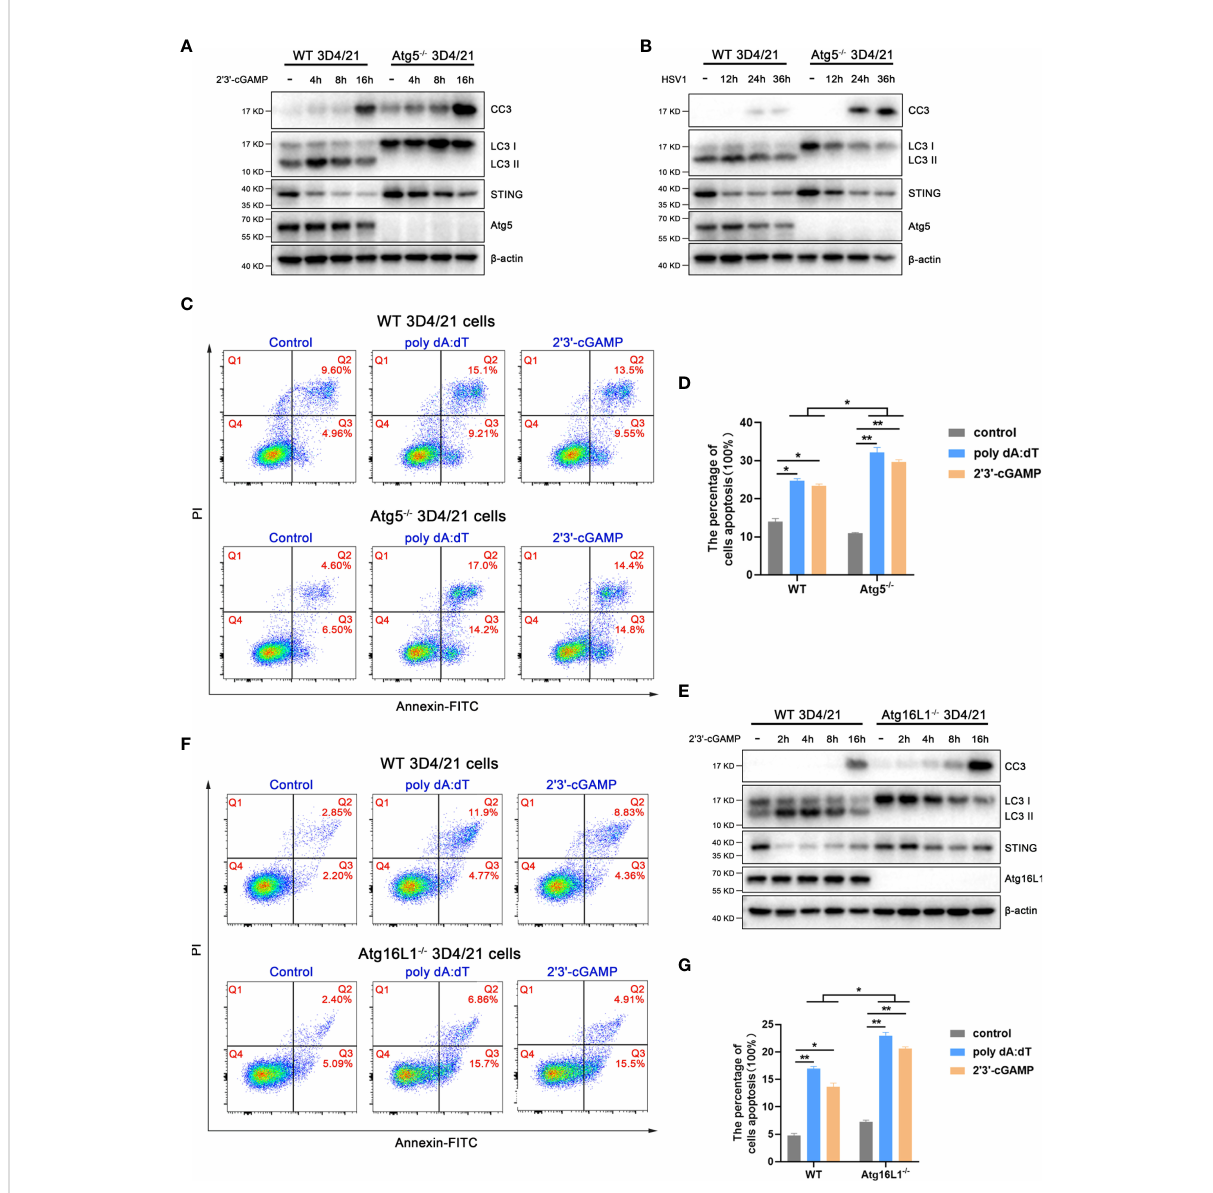
FIGURE 7 STING induced autophagy promotes STING degradation and inhibits apoptosis. (A, B) Wild type and Atg5 -/- 3D4/21 cells were stimulated by 2 ’ 3 ’ -cGAMP (1 m g/mL) (A) or HSV1 (0.01 MOI) (B) for the indicated times, followed by Western blotting. (C, D) Wild type and Atg5 -/- 3D4/21 cells were stimulated by poly dAdT or 2 ’ 3 ’ -cGAMP (each 1 m g/mL) for 16 h, followed by fl ow cytometry analysis of cell apoptosis. * p < 0.05 and ** p < 0.01. (E) Wild type and Atg16L1 -/- 3D4/21 cells were stimulated by 2 ’ 3 ’ -cGAMP (1 m g/mL) for the indicated times, followed by Western blotting. (F, G) Wild type and Atg16L1 -/- 3D4/21 cells were stimulated by poly dA:dT or 2 ’ 3 ’ -cGAMP (each 1 m g/mL) for 16 h, followed by fl ow cytometry analysis of cell apoptosis. * p < 0.05 and ** p <